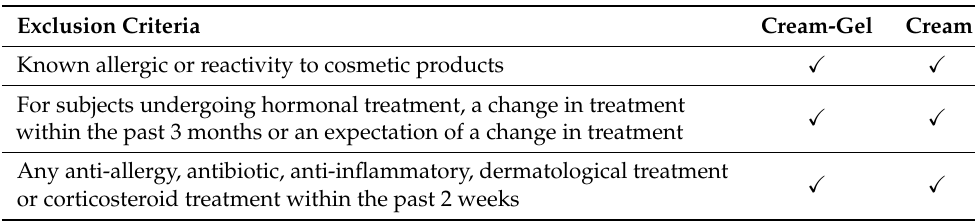
Table 2. Exclusion criteria of the observational clinical studies. Check Marks (cid:88) means yes, and X means no. The exclusion criteria were the same for testing both the formulations. Exclusion Criteria Cream-Gel